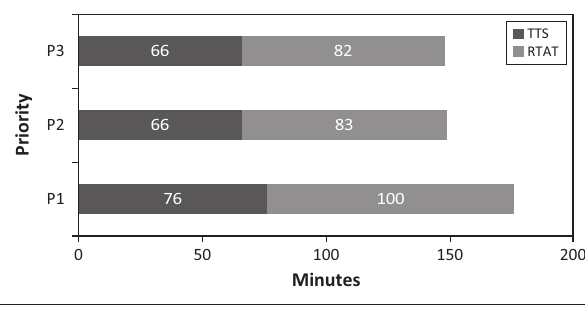
FIGURE 4: Time to scan (TTS) and report turnaround time (RTAT) compared with the triage priority of the patient.